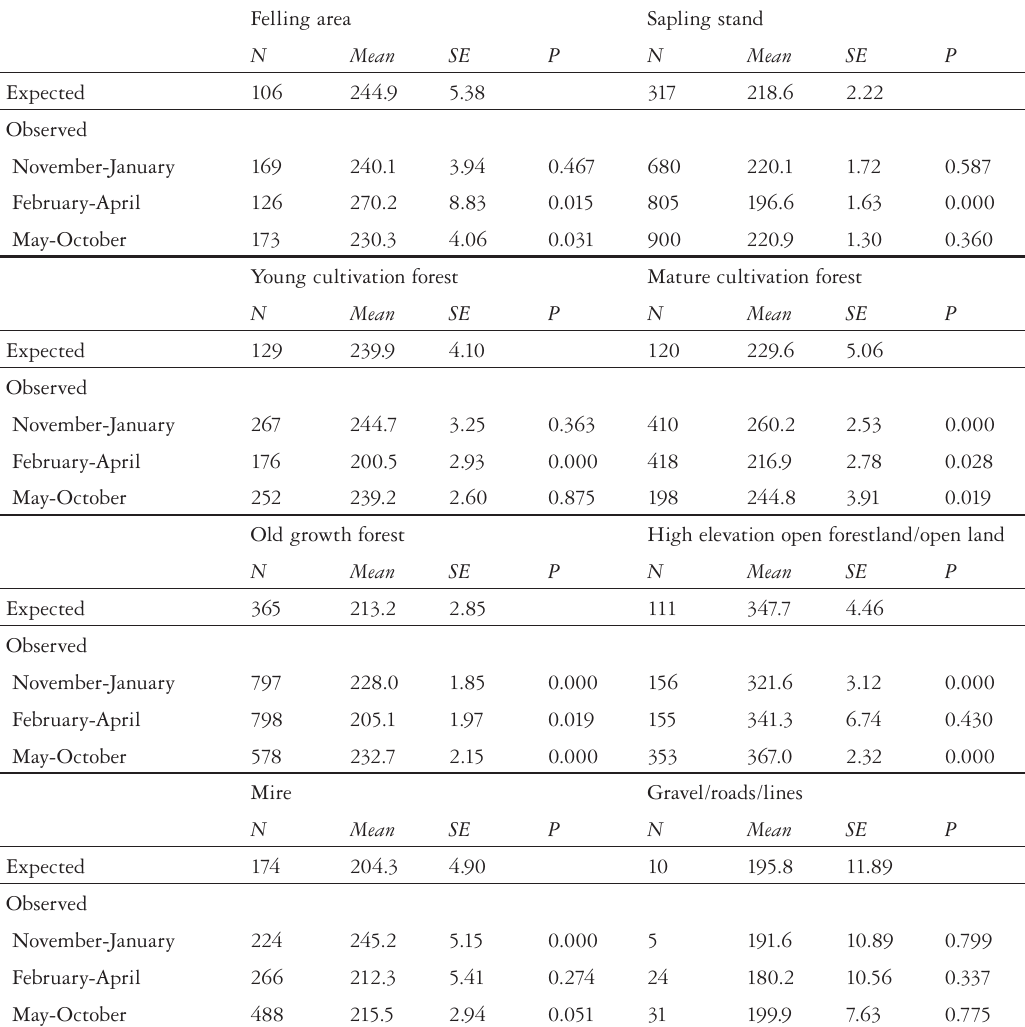
Table 4. Difference in mean altitude (m) between expected (random) and observed (GPS tracking of reindeer) locations within each forest and landscape class and seasonal period ( N , Mean , SE (Standard Error) and P -values in t -